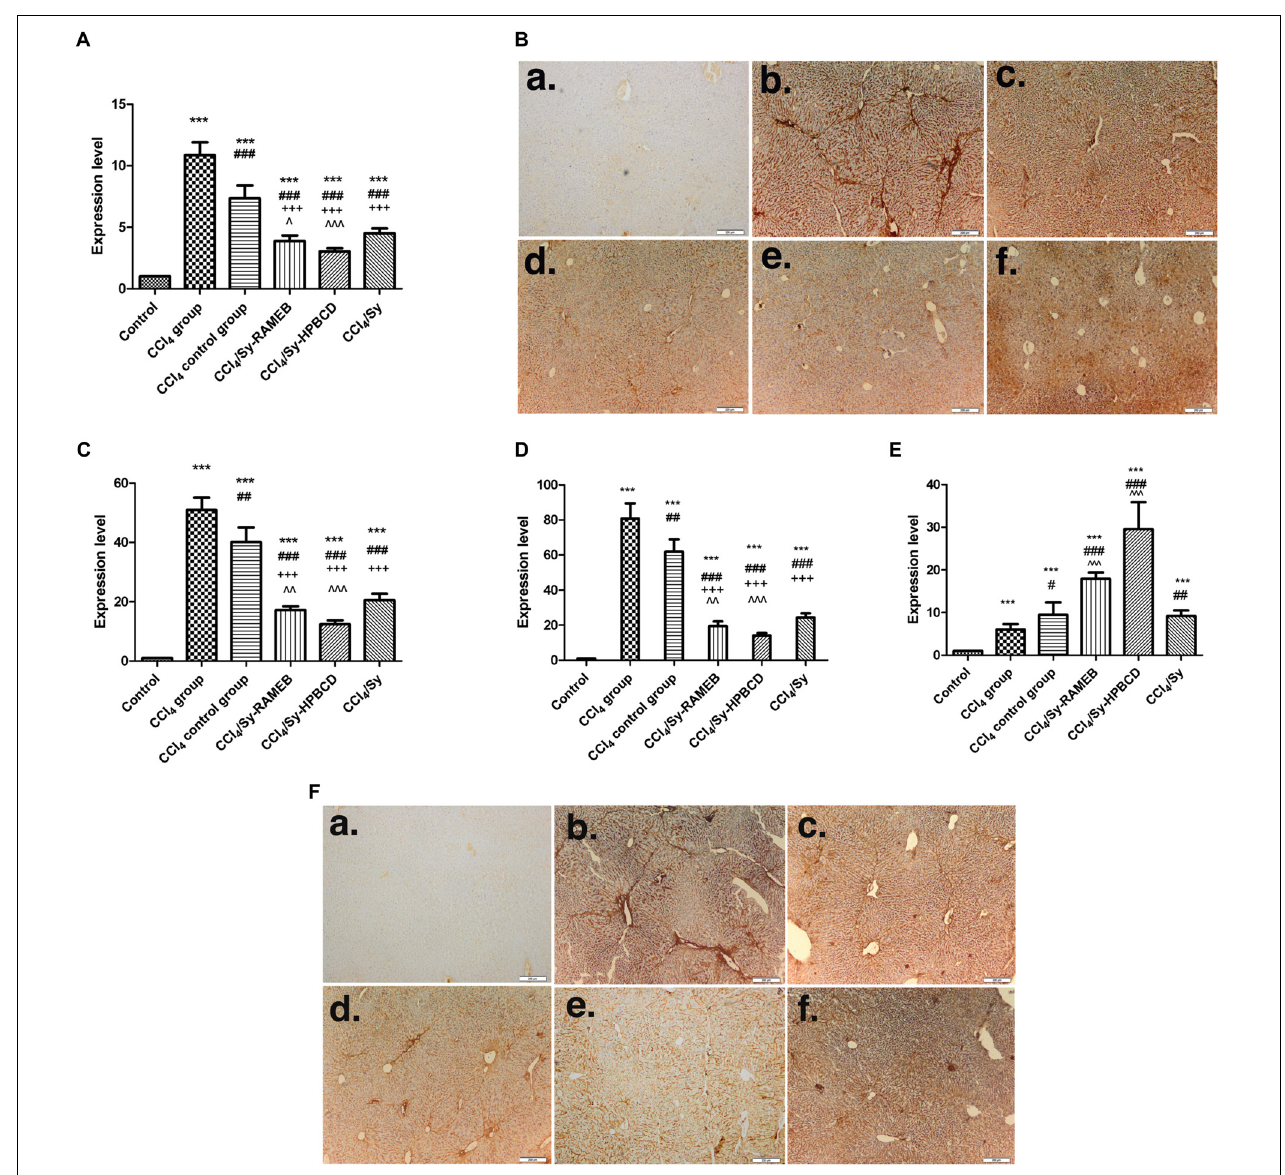
FIGURE 7 | Effects of Sy-HPBCD and Sy-RAMEB complexes on TGF- β 1/Smad signaling pathway. (A) RT-PCR analysis of TGF- β 1 gene level. ∗∗∗ p < 0.001 compared to control; ### p < 0.001 compared to CCl 4 group; +++ p < 0.001 compared to CCl 4 control group; ˆ p < 0.05 compared to CCl 4 /Sy group; ˆˆˆ p < 0.001 compared to CCl 4 /Sy group. (B) Immunohistochemical expression of TGF- β 1 in experimental livers. (a) Control group, (b) CCl 4 -treated group, (c) CCl 4 -control group, (d) CCl 4 and Sy-RAMEB co-treated group, (e) CCl 4 and Sy-HPBCD co-treated group, (f) CCl 4 and free Sy co-treated group; RT-PCR analysis of Smad 2 (C) , Smad 3 (D), and Smad 7 (E) gene levels. ∗∗∗ p < 0.001 compared to control; # p < 0.05 compared to CCl 4 group; ## p < 0.01 compared to CCl 4 group; ### p < 0.001 compared to CCl 4 group; +++ p < 0.001 compared to CCl 4 control group; ˆˆ p < 0.01 compared to CCl 4 /Sy group; ˆˆˆ p < 0.001 compared to CCl 4 /Sy group. (F) Immunohistochemical expression of Smad 2/3 in experimental livers. (a) Control group, (b) CCl 4 -treated group, (c) CCl 4 -control group, (d) CCl 4